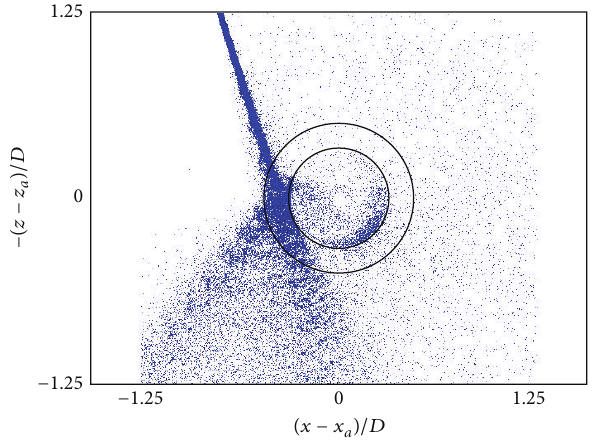
Figure 5: Distribution of superimposed particles when 𝜆 = 0.56 .